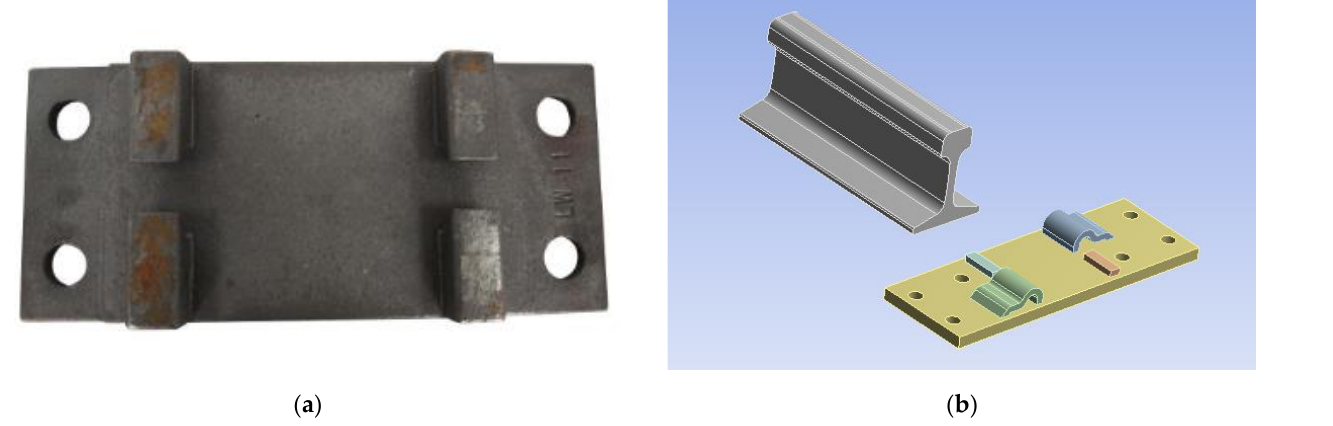
Figure 17. Improvement in baseplate design: ( a ) before improvement of the baseplate and ( b ) after improvement of the baseplate.